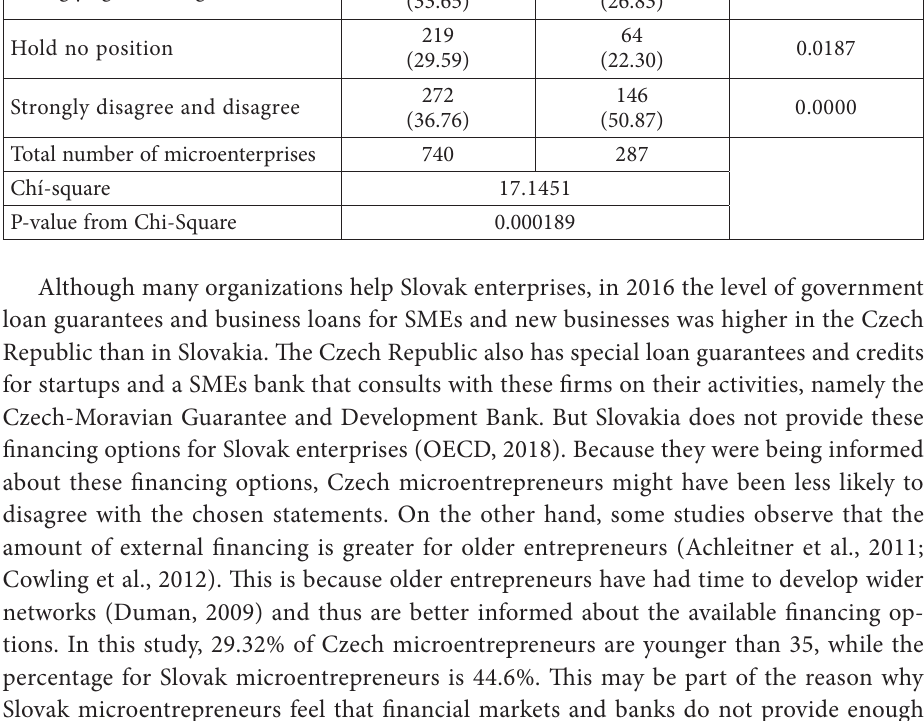
Table 3. Differences in the perception of microenterprises’ financing from banks (source: own processing) Banks accept our needs and help